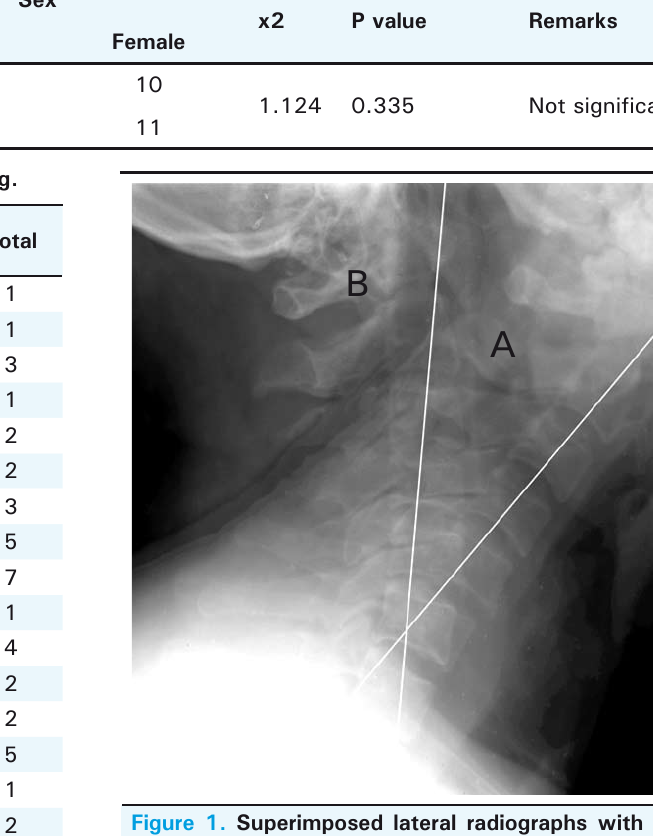
table 6. Significance of difference in the prevalence of cervical spondylosis in male and female. Spondylosis